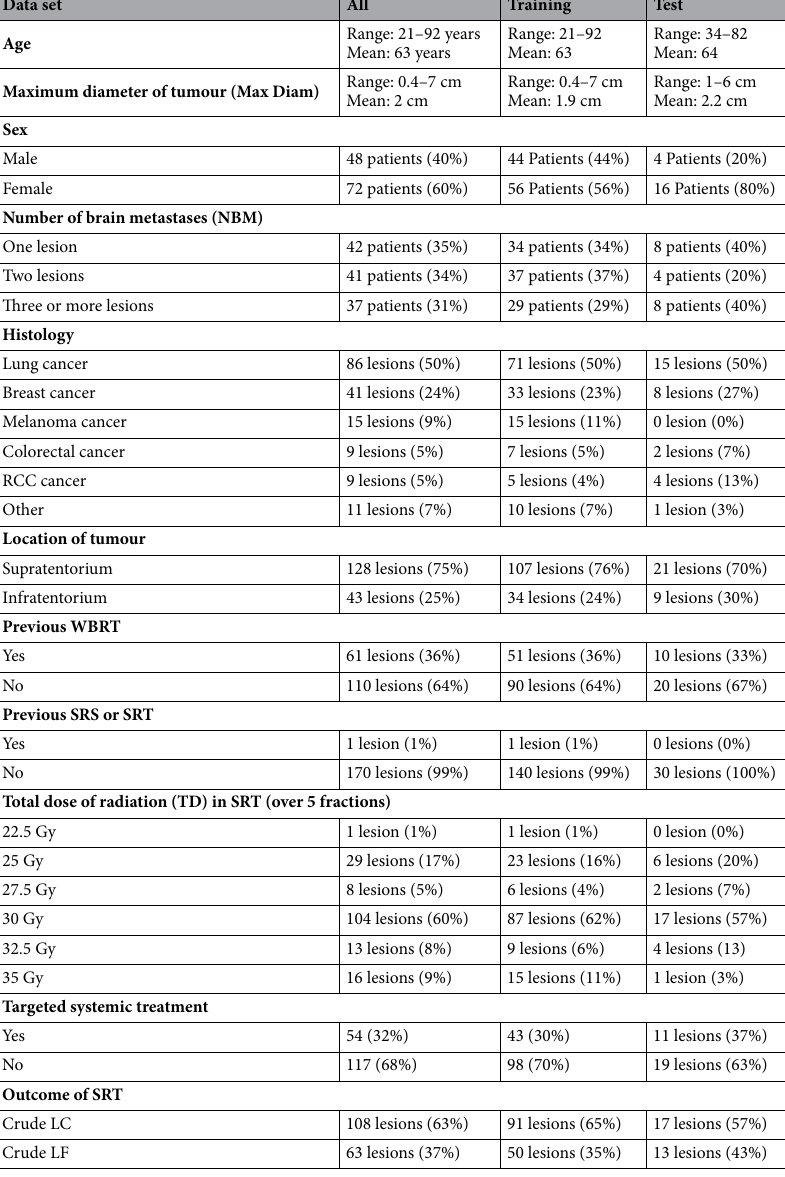
Table 1. Patient characteristics and SRT